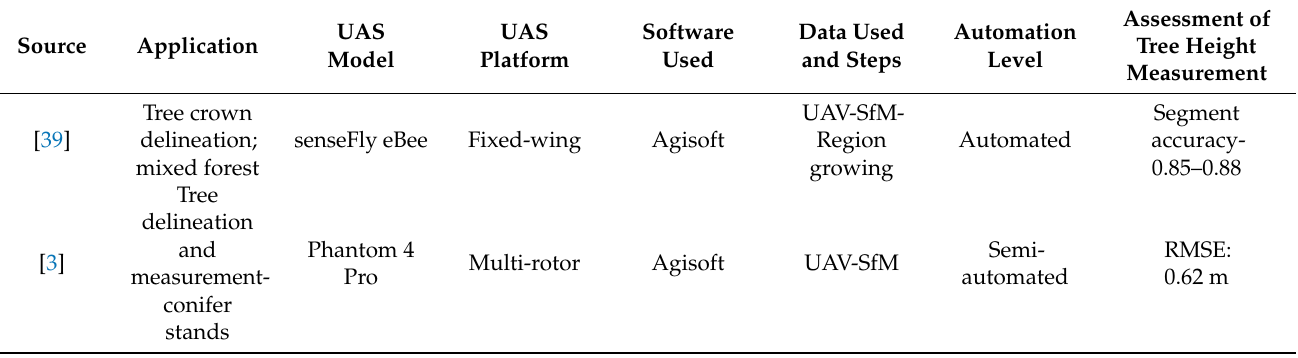
Table A1. Summary of selected works to illustrate forest measurement practices and the accuracy using UAS